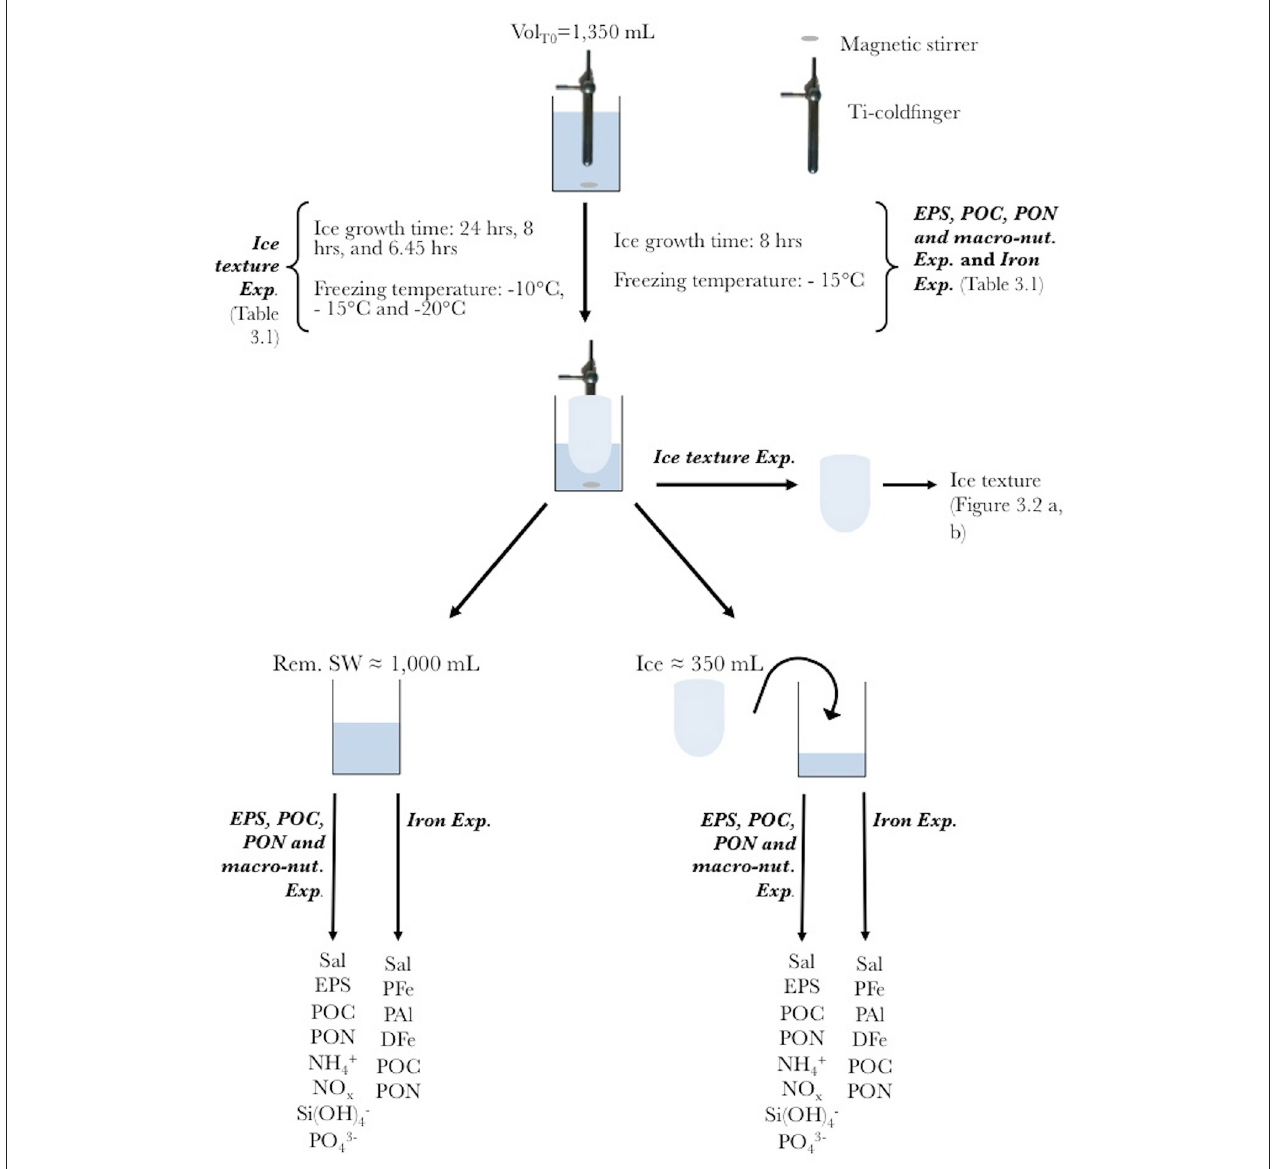
FIGURE 1 | Schematic of the cold-finger experiment for the Ice texture Experiment ( Ice texture Exp. ), the Extracellular polymeric substances, POC, PON, and macro-nutrients experiment ( EPS, POC, PON, and macro-nut Exp .) and the iron experiment ( Iron Exp. ). The entire set-up was placed in a custom-made clean plastic bubble ( Ice texture Exp. and EPS, POC, PON, and macro-nut. Exp. ), or under a laminar flow hood ( Iron Exp. ). The cold-finger was connected to a circulating water bath with ethanol (not shown). Experiments were run in triplicate. For each experiment the volume at T 0 was 1,350mL. The ice was formed at − 10, − 15, and − 20 ◦ C for 24, 8, and 6.45h respectively for the Ice texture Exp ., and − 15 ◦ C for 8h for the EPS, POC, PON, and marco-nut. Exp. and the Iron Exp . Once formed, the ice was removed from the cold-finger, and processed for ice texture ( Ice texture Exp. ), or allowed to melt in the dark at room temperature before further processing ( EPS, POC, PON, and macro-nut. Exp. and Iron Exp. ). Both remaining seawater (Rem. SW) and ice were processed for parameters described in the method